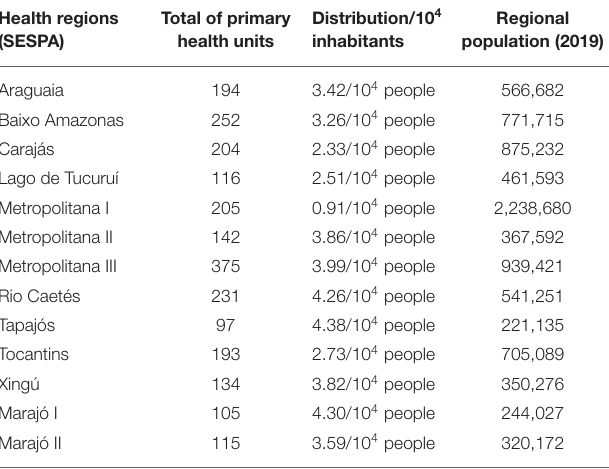
TABLE 1 | The distribution of primary health units among Pará’s regions. Health regions (SESPA)